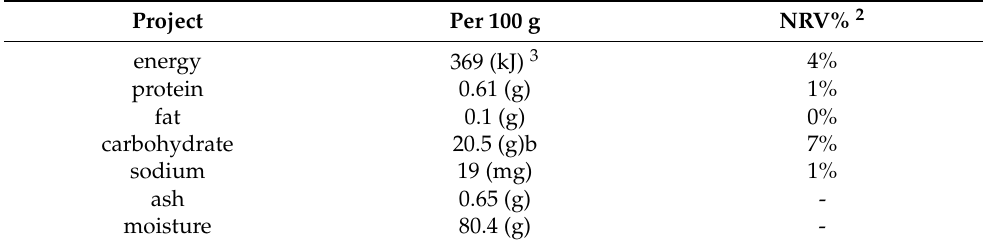
Table 5. Nutritional composition of the optimal FKJ 1 .